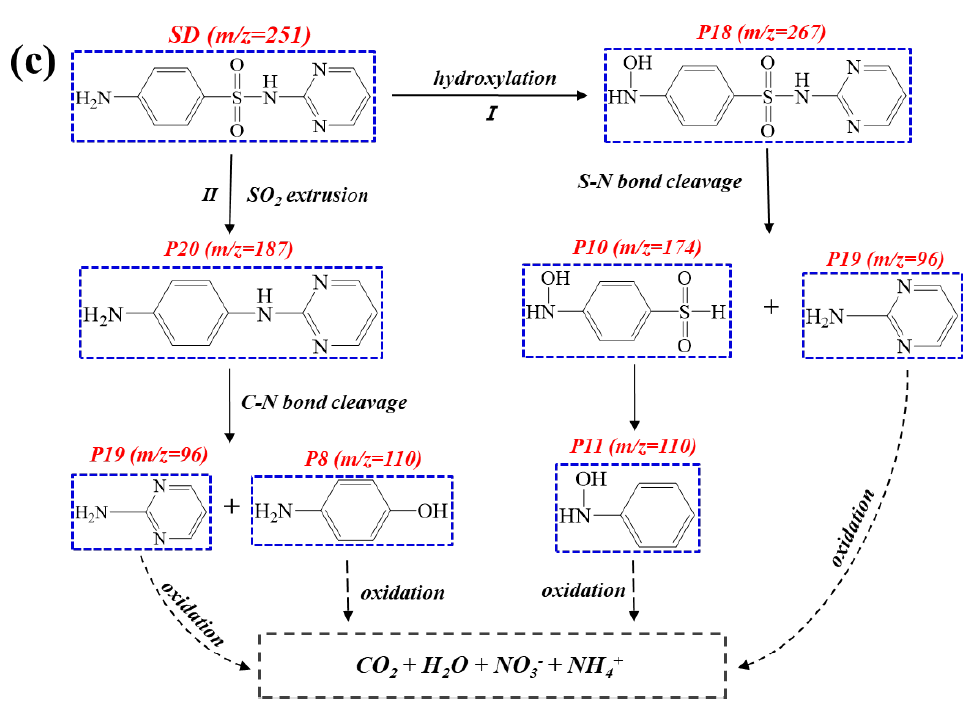
Figure 5. Possible degradation pathways of ( a ) SM2, ( b ) SMX, and ( c ) SD in Bi/mZVI+CA+NaCA system.